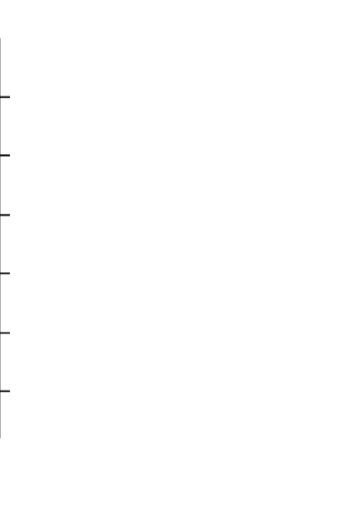
Fig 2. Serum folate concentration in folic acid and MTHFR groups over time.